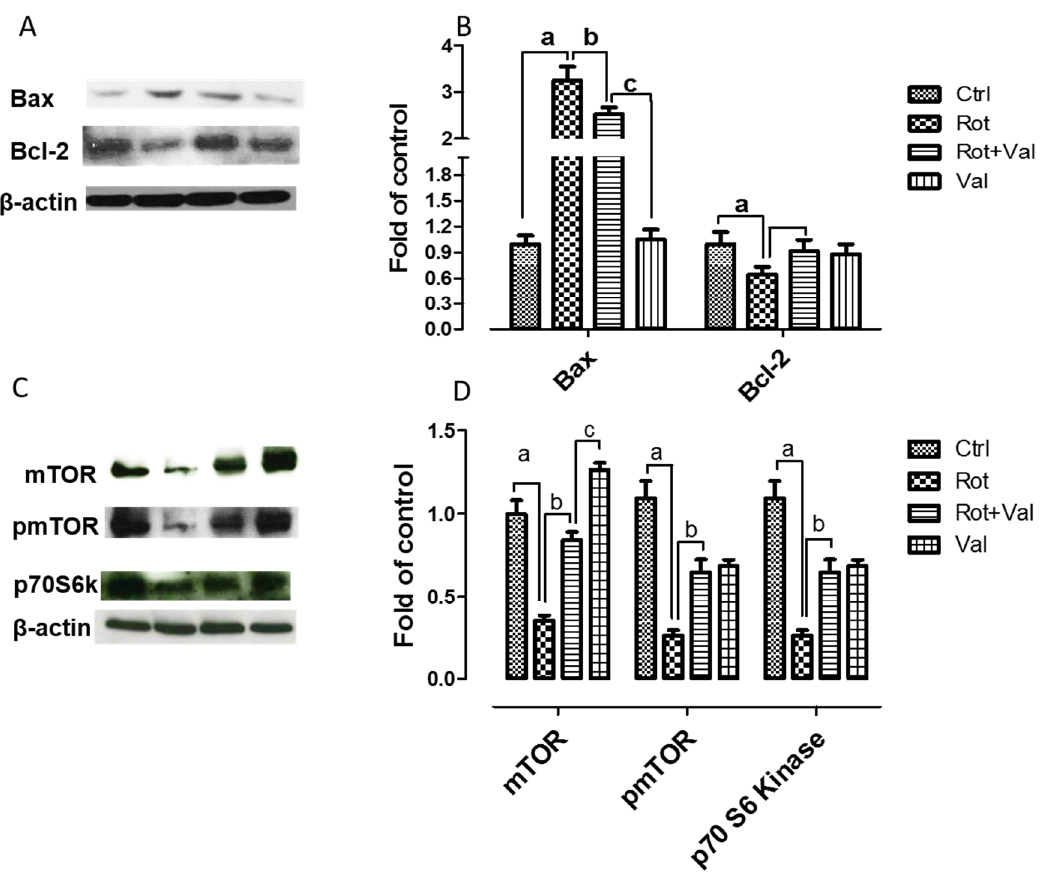
Figure 6. Valeric acid prevented rotenone mediated neuronal apoptosis by restoring mTOR pathway. Immunoblotting of midbrain samples with mTOR pathway ( A ) proteins and apoptotic markers ( C ). Blots for phosphor mTOR and p70S6K ( B ), Bax and Bcl-2 ( D ) mTOR were quantified using Image J and represented as fold of control. Values are expressed as mean ± SEM. a p < 0.05 compared to control, b p < 0.05 compared to rotenone treated group, c p < 0.05 compared to Rot + Val treated group.